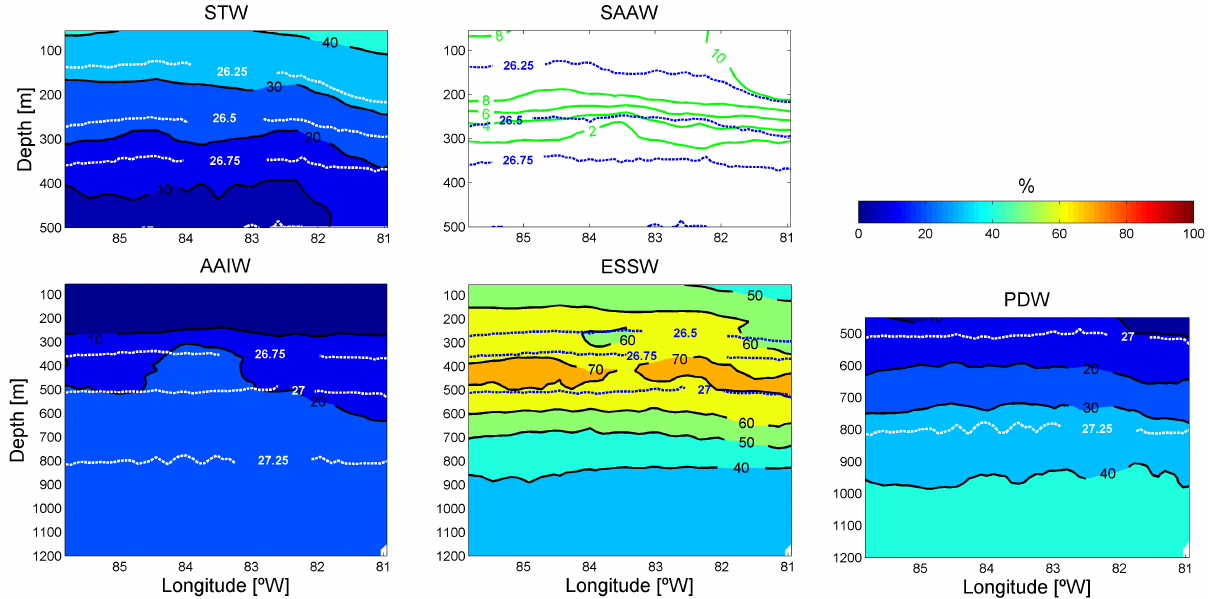
Fig. 5. Water mass distribution (%) along the 3 ◦ 35 0 S section between 85 ◦ 50 0 W and the continental shelf for the M77 cruise (February 2009), for subtropical water (STW), subantarctic water (SAAW), antarctic intermediate water (AAIW), equatorial subsurface water (ESSW) and pacific deep water (PDW) as defined in Table 1. Selected isopycnals are shown as dotted white/blue